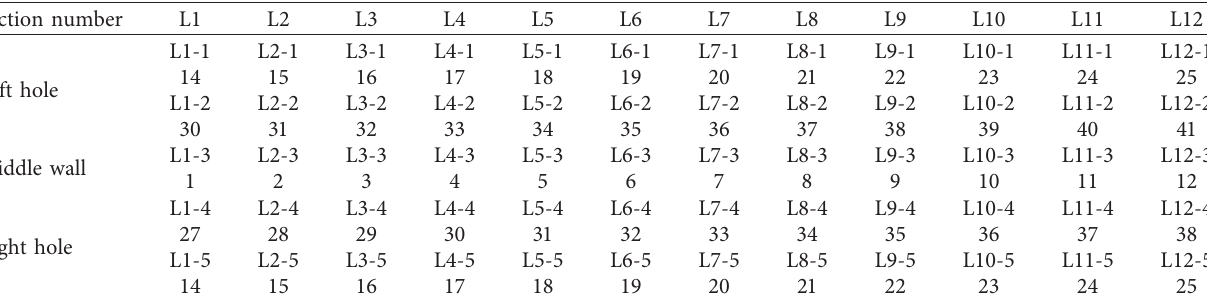
Figure 3: Main test procedure. Table 2: Excavation sequence of excavation scheme I.